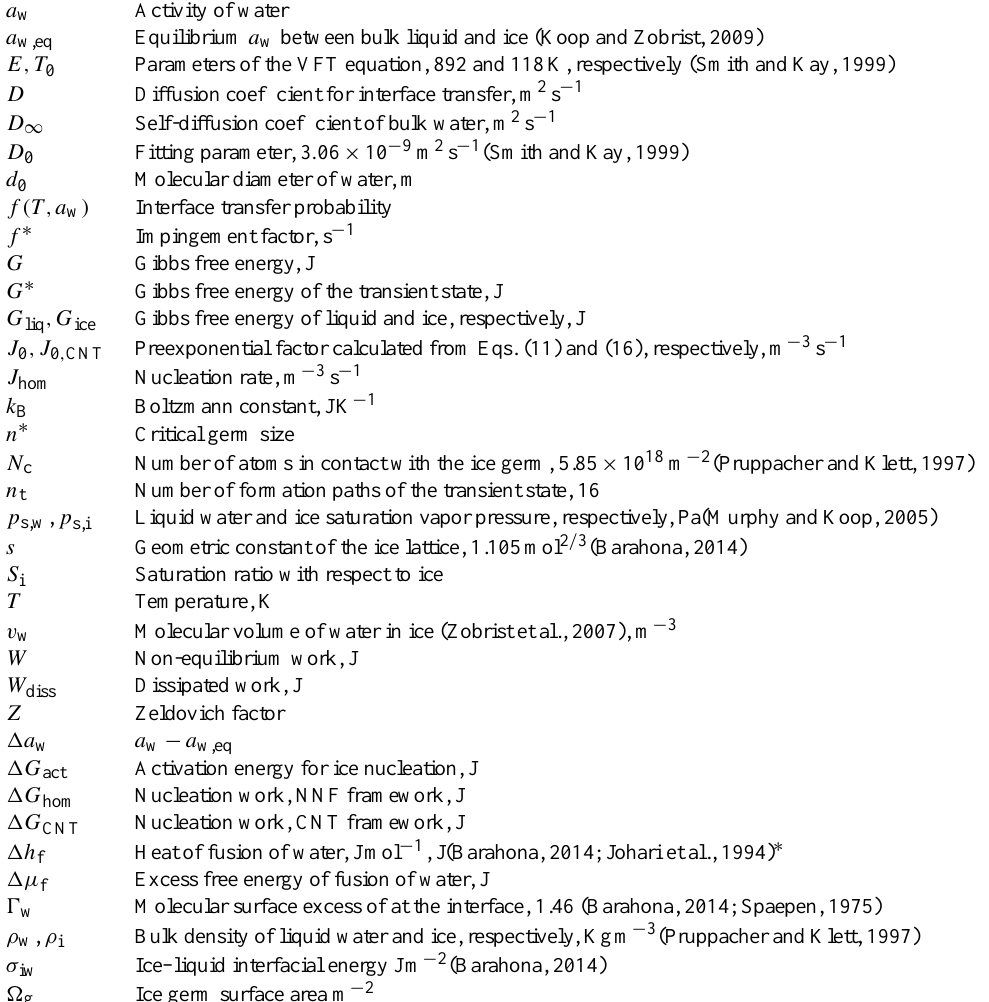
Table 1. List of